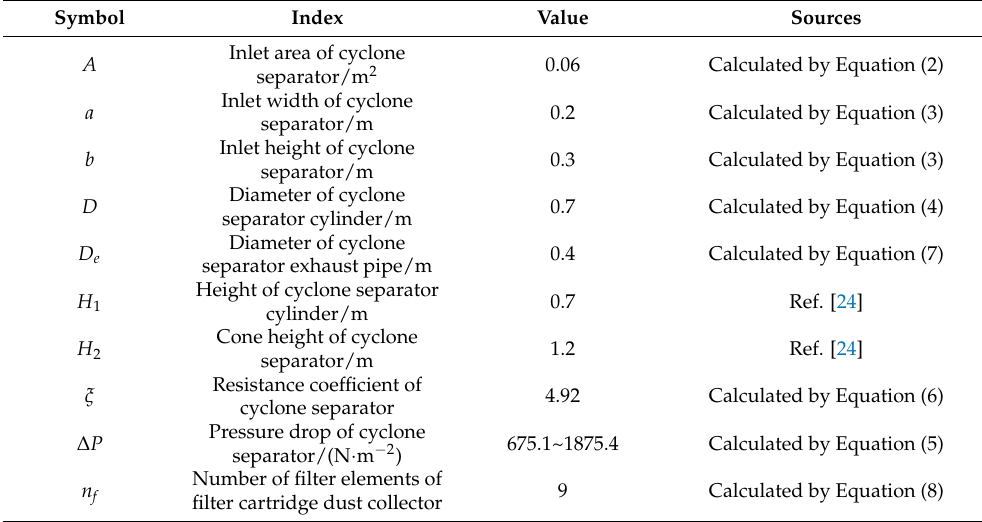
Table 1. Key parameters of total amount dust collection